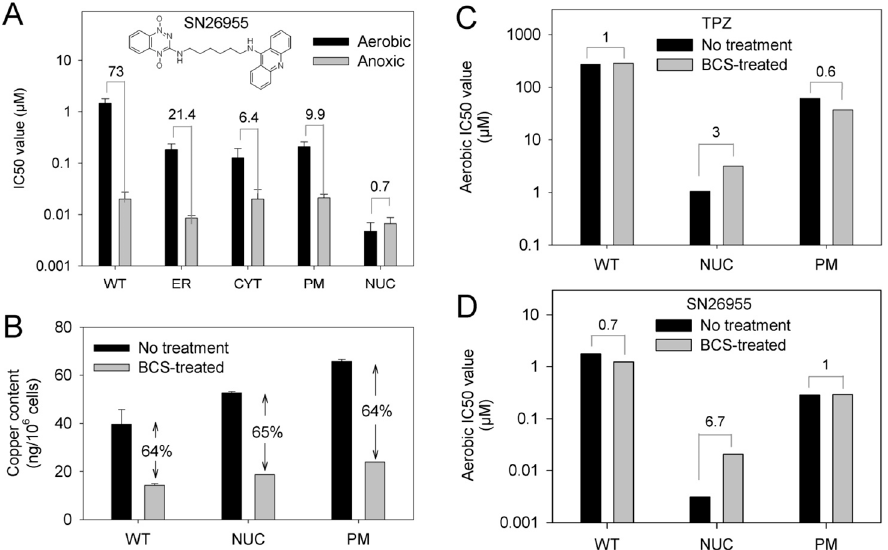
Figure 6. Aerobic toxicity of TPZ and an analogue with increased affinity for DNA is mediated by a copper-dependent mechanism in MDA-231 NUC cells: ( A ) Sensitivity of parental and transfected MDA-231 cell lines to SN26955, which contains a TPZ moiety linked to a DNA intercalator, under aerobic conditions as determined by antiproliferative assay. IC 50 values show the mean of 3-4 independent experiments, error bars show the SEM; numbers are the HCR values. ( B ) Quantitation of the copper content of cells incubated for 7 days in normal media or media supplemented with the copper chelating agent bathocuproine (BCS) as determined by ICP-MS analysis. ( C ) Effects on chronic BCS exposure on the aerobic sensitivity of parental, MDA-231 NUC or MDA-231 PM cells to TPZ as determined by anti-proliferative assay. ( D ) Effects on chronic BCS exposure on the aerobic sensitivity of parental, MDA-231 NUC or MDA-231 PM cells to SN26955 as determined by anti-proliferative assay.